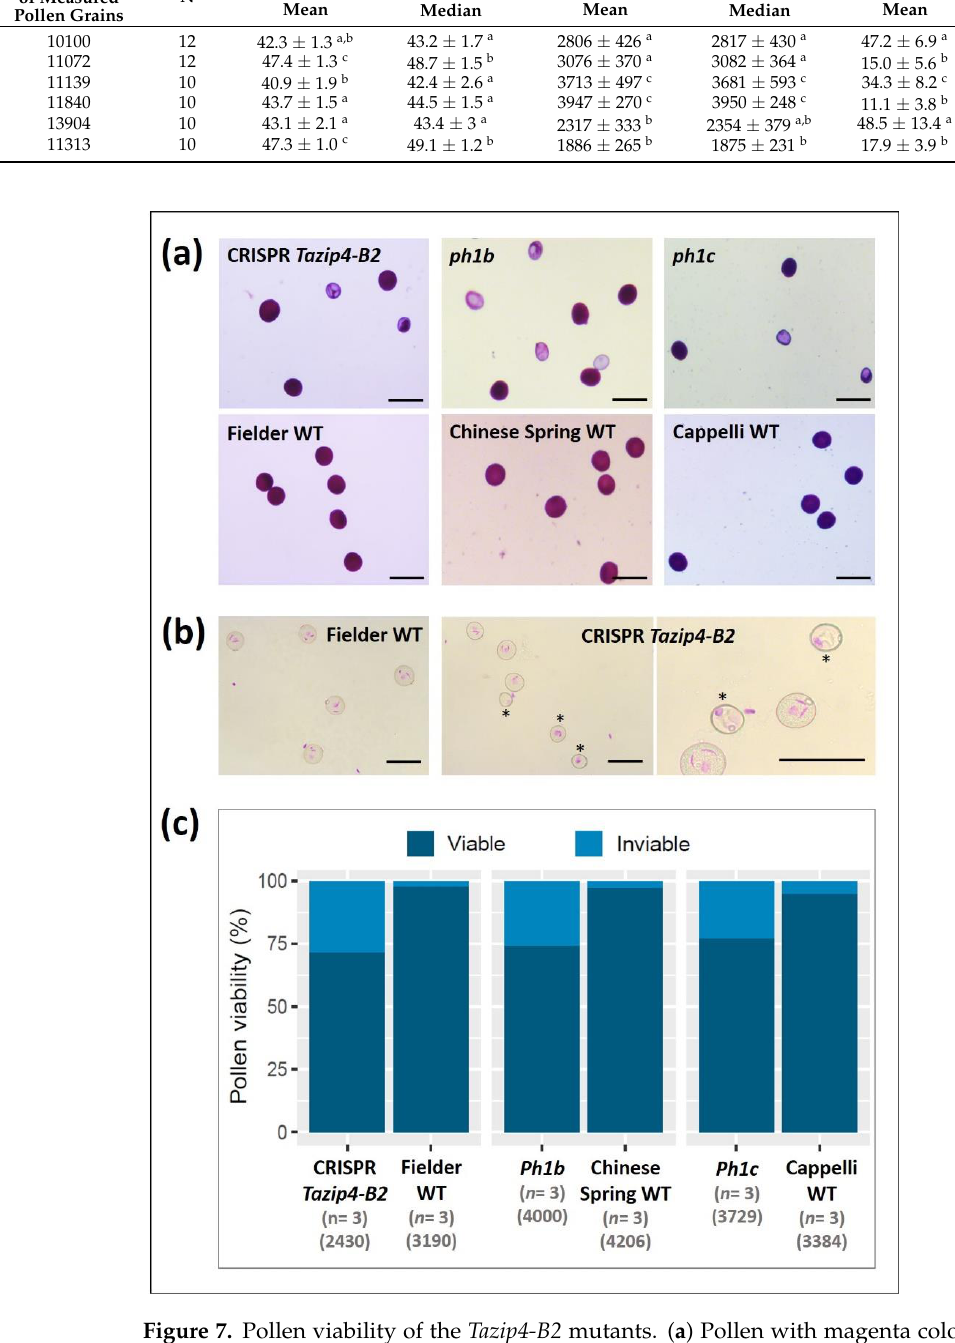
Table 4. Pollen number and pollen grain size for the three Tazip4-B2 mutants and their corresponding wild types. Mean and median values with standard deviations are shown. Treatments with the same letter are not significantly different. Genotype